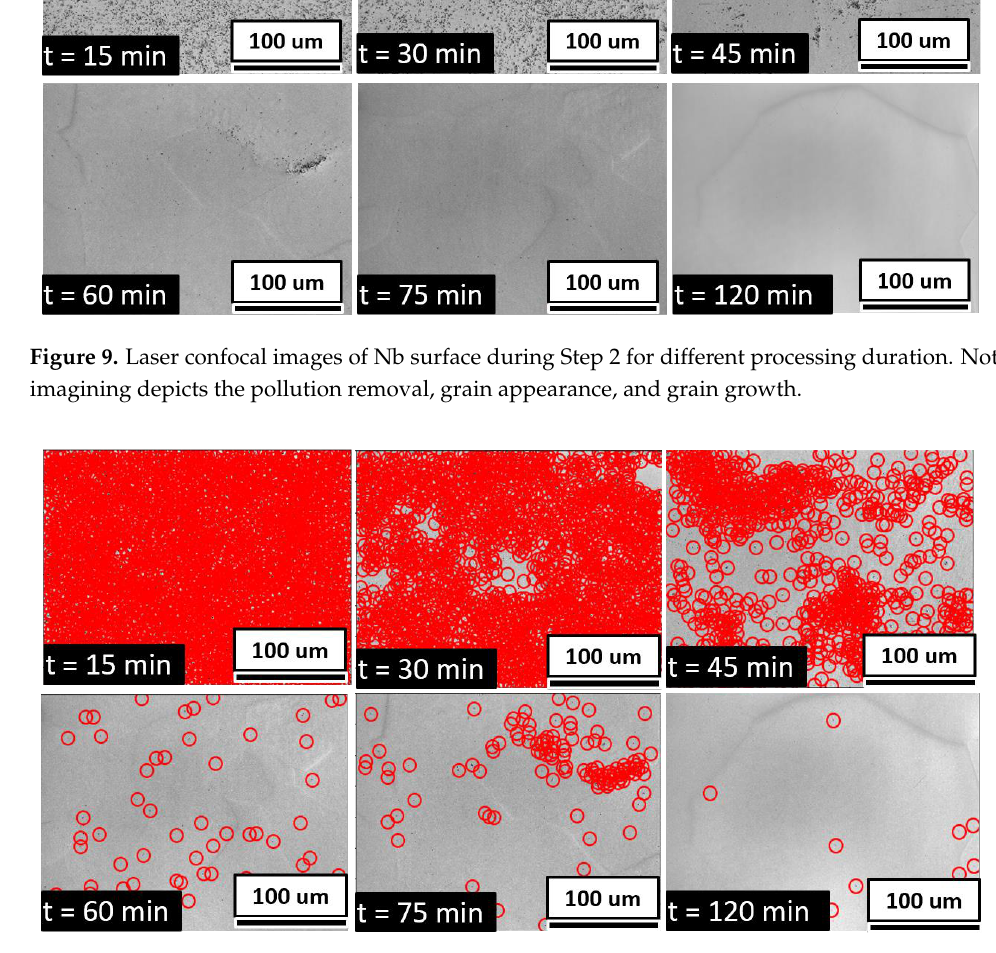
Figure 11. Laser confocal images, optical image, and topography of the Nb sample after Step 2. Figure 12. The calculated number of embedded particles versus polishing time.